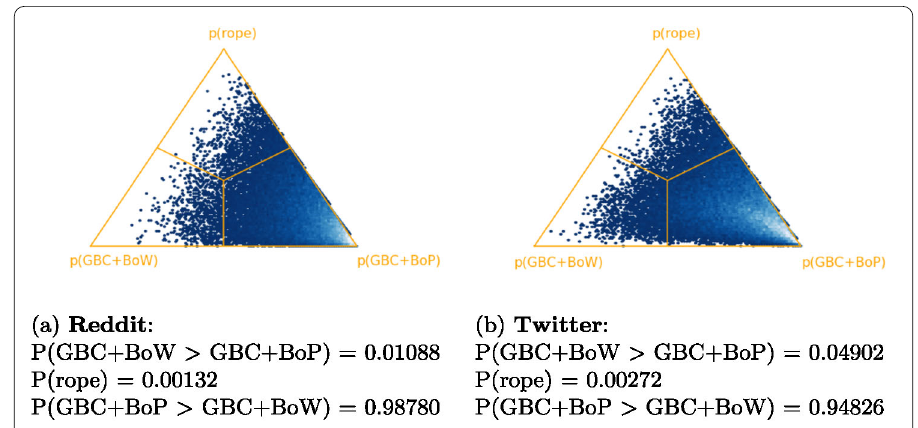
Figure 3 Results of the Bayesian Hierarchical test comparing the gender-based classifiers (GBC) using the BoP and BoW